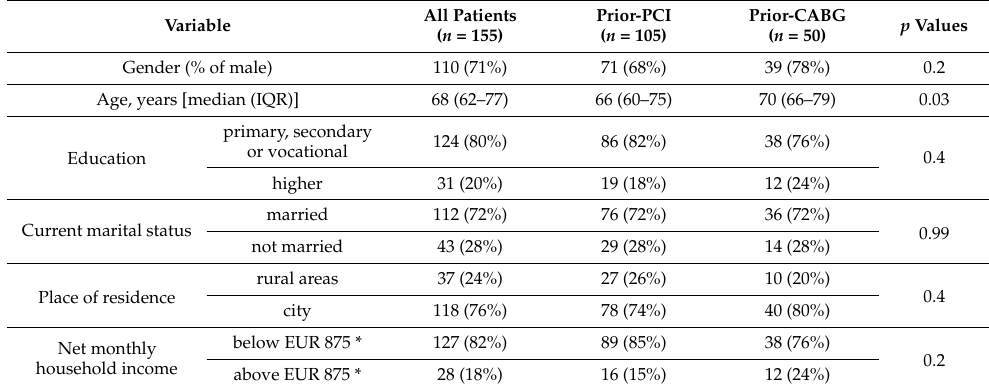
Table 1. Comparison of sociodemographic profile.